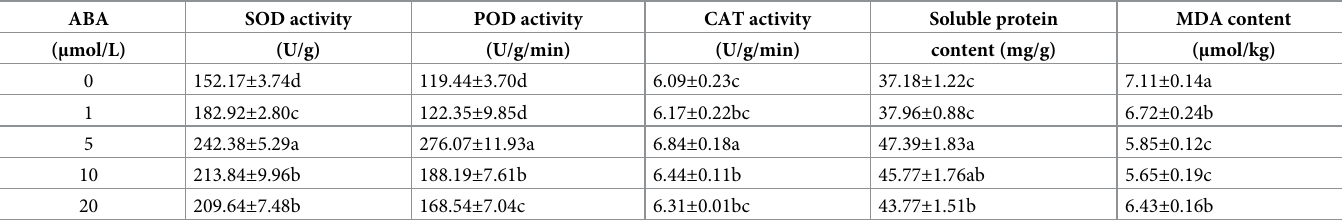
Table 3. Antioxidant enzyme activity, soluble protein content, and MDA content of P . frutescens .